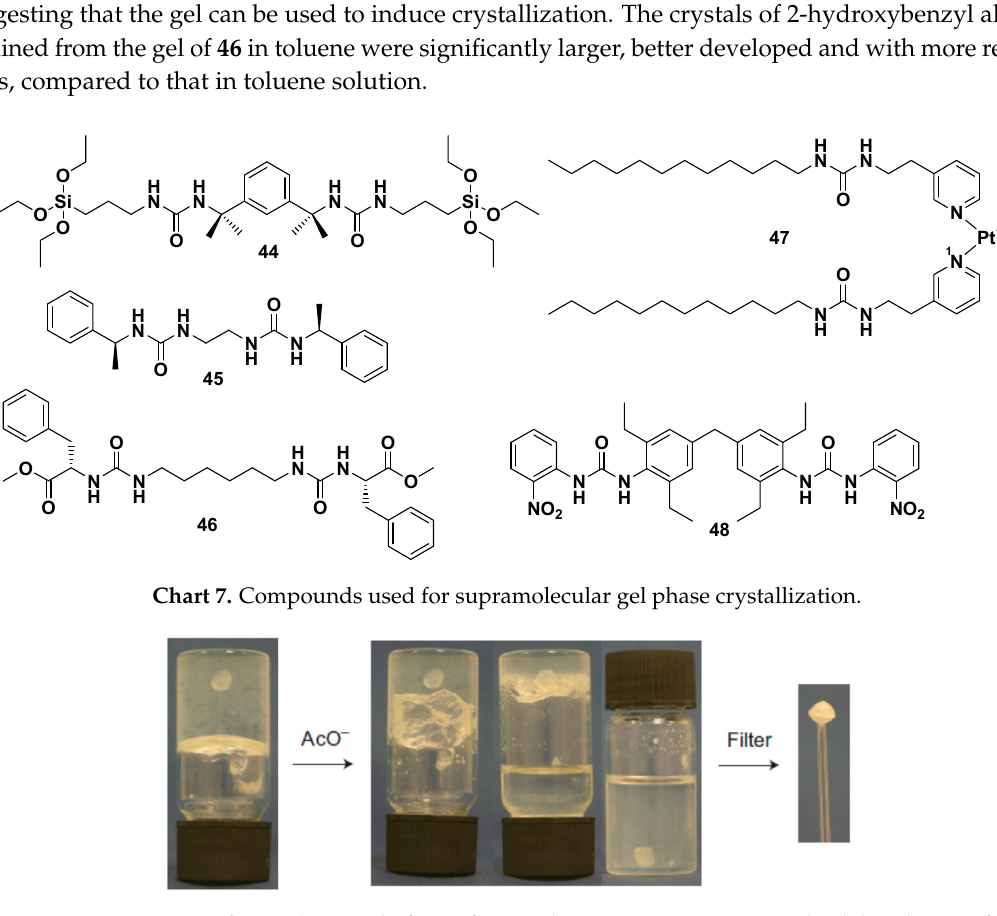
Figure 12. Recovery of a single crystal of CBZ form III by acetate-anion triggered gel dissolution of a 1:9 CHCl 3 : toluene gel of gelator 46 . Reproduced with permission from Reference [92].